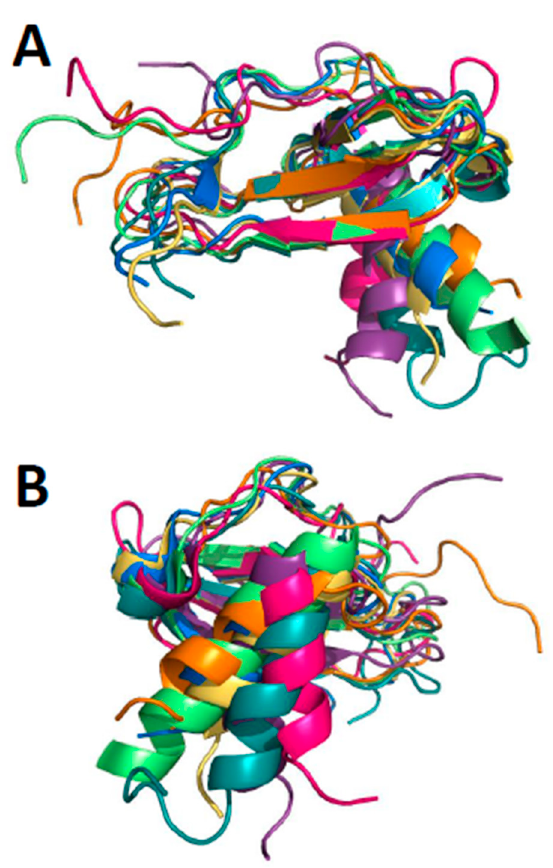
Figure 1. Superposition of seven monomer subunits from reported structures of CXC and CC chemokine homodimers is shown: CXCL4 M2 variant (Protein Data Bank, PDB: 1PFM), CXCL8 (PDB: 1IL8), CXCL12 (PDB: 3HP3), CXCL13 (PDB: 4ZAI), CCL5 (PDB: 5COY), CCL14 (PDB: 2Q8R), and CCL20 (PDB: 1HA6). ( A ) Only atoms within the three-stranded β -sheet are superimposed with RMSD values ranging between ~1.3 and ~1.7 Å; ( B ) Superimposed structures shown in panel A are rotated by about 180 ◦ to illustrate how C-terminal helices are folded onto the β -sheet at somewhat different